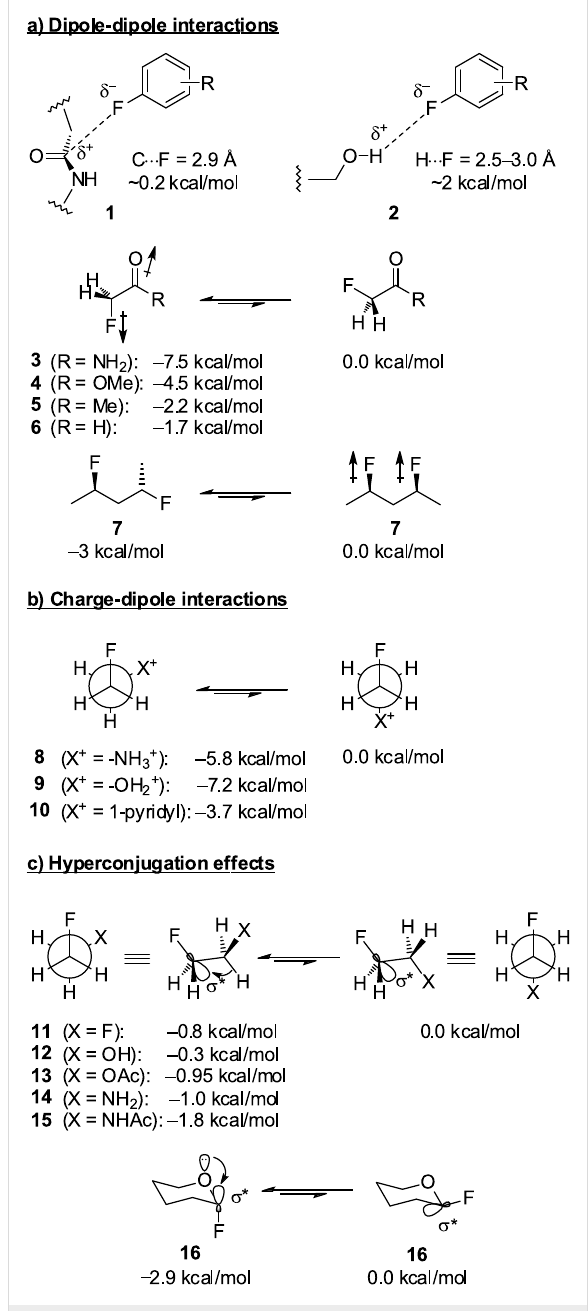
Figure 1: Conformational effects associated with C–F